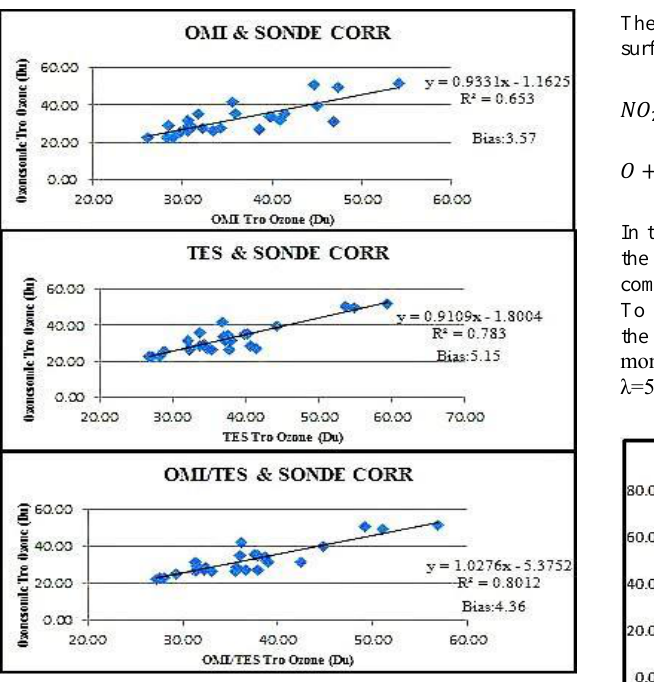
Figure 9- correlation values of the satellite tropospheric ozone with Ozonesonde in non-urban area